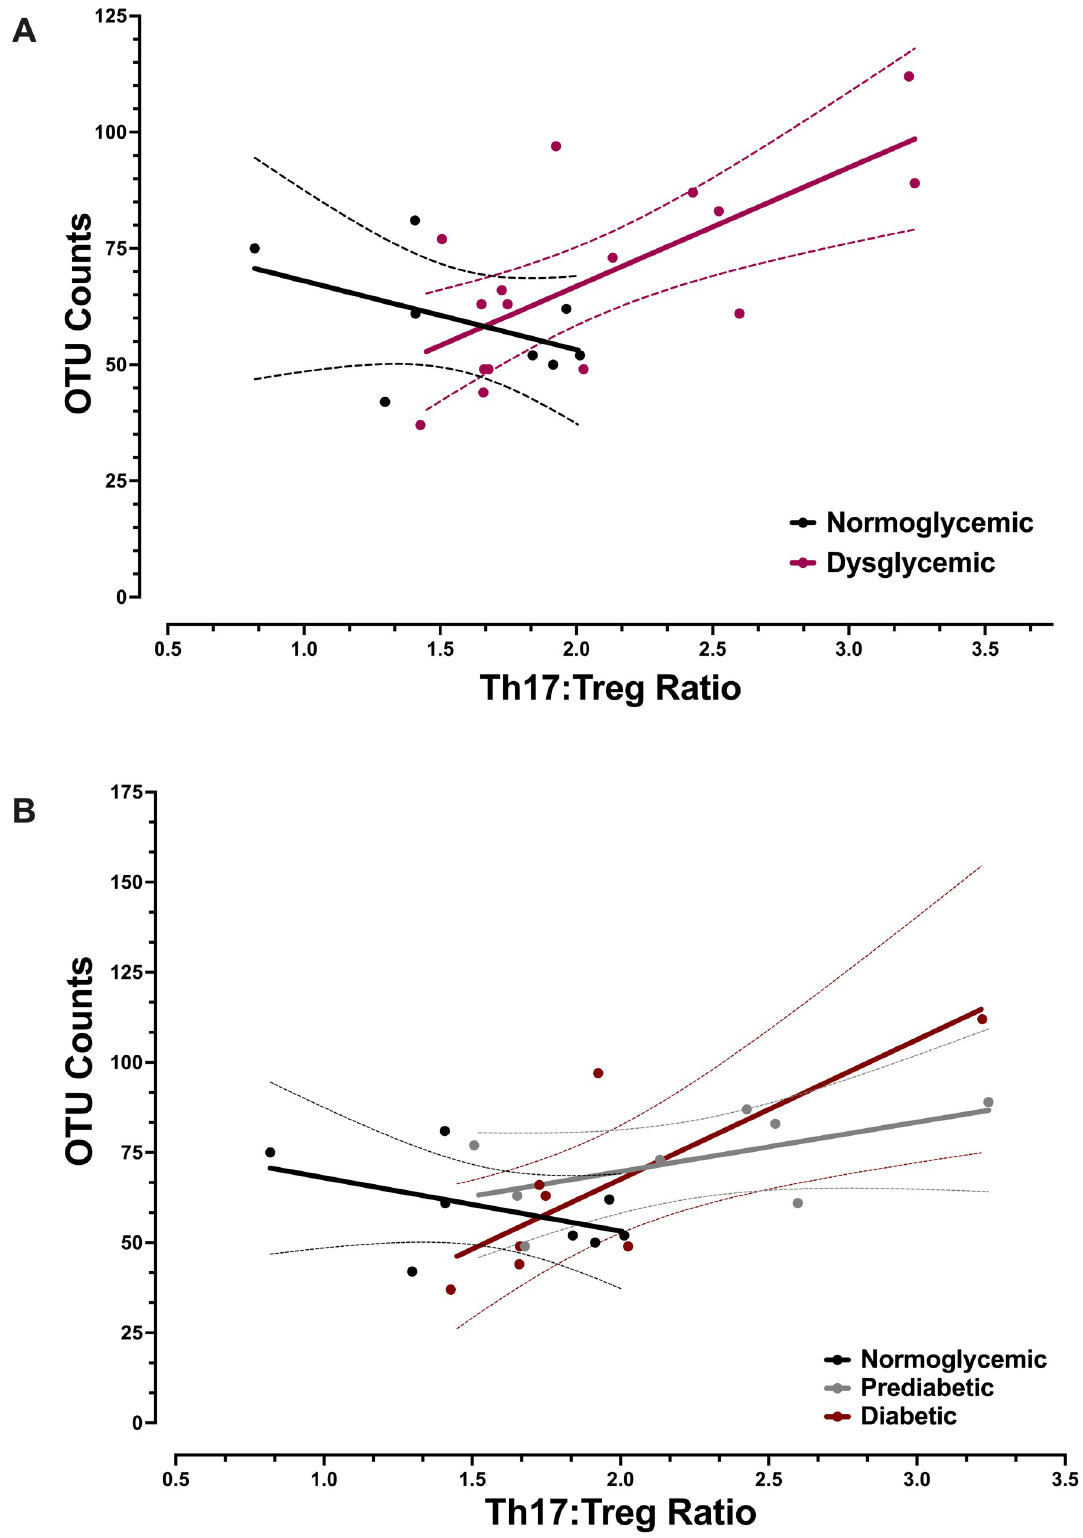
Fig 3. Impact of Th17:Treg ratios on alpha diversity of the stool microbiome by diabetes phenotype. Linear regression of OTU counts from Presort stool samples on Th17:Treg ratios by (A) normoglycemia and dysglycemia profiles, p-value of < 0.066